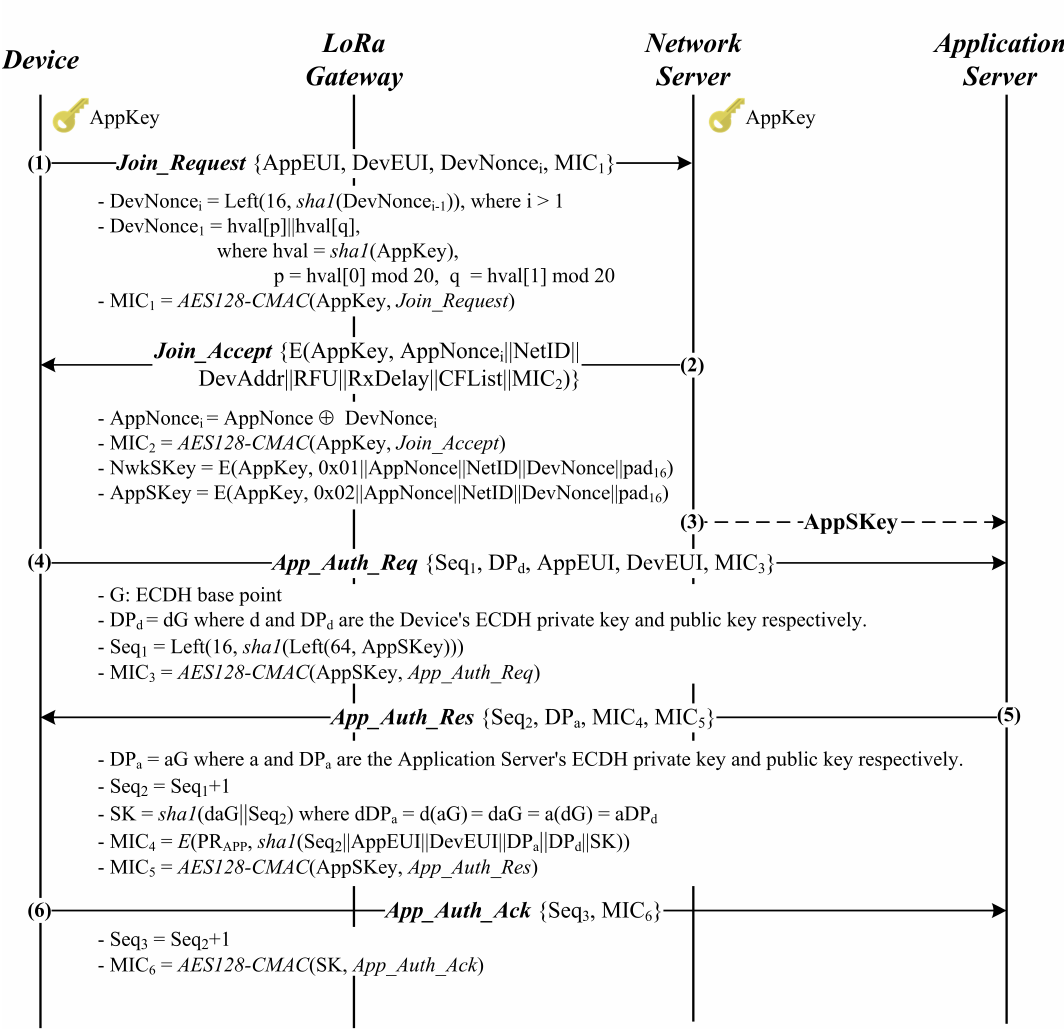
Figure 4. DevNonce